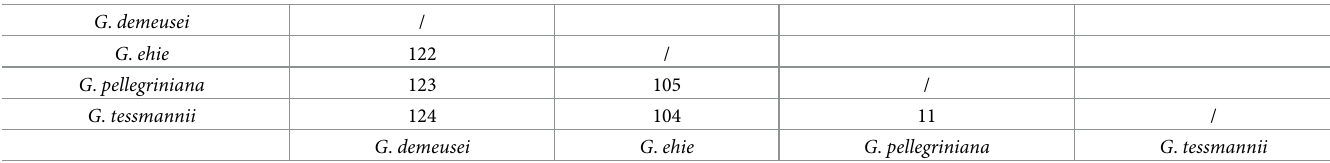
We searched for genetic markers for the discrimination of the two Milicia species, M . excelsa and M . regia . We analyzed individuals collected in Western African regions in which the two species are either isolated or sympatric (Ghana, Ivory Coast). Furthermore, we also processed individuals of M . excelsa collected in Central Africa (S1 Table). The genetic comparison of the complete ptDNA (S10 File) shows that the two species differ only in 8 polymorphic sites, four of them located in coding regions and two occurring in intron regions. In the nrDNA (S11 File), ITS1 and ITS2 have a lower discriminative power (2 and 1 SNPs, respectively) while ETS Table 7. SNP variation in the plastid intron regions among Guibourtia species. G .